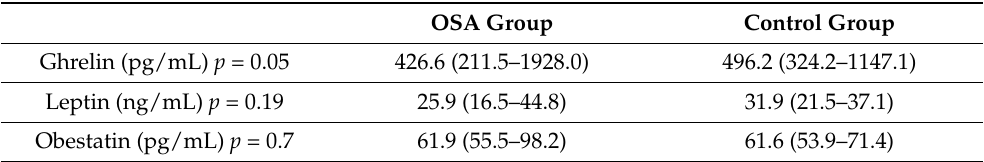
Figure 4. Night levels of ghrelin in subgroups classified according to BMI values (statistically significant correlation is marked using *). IQR—interquartile range.